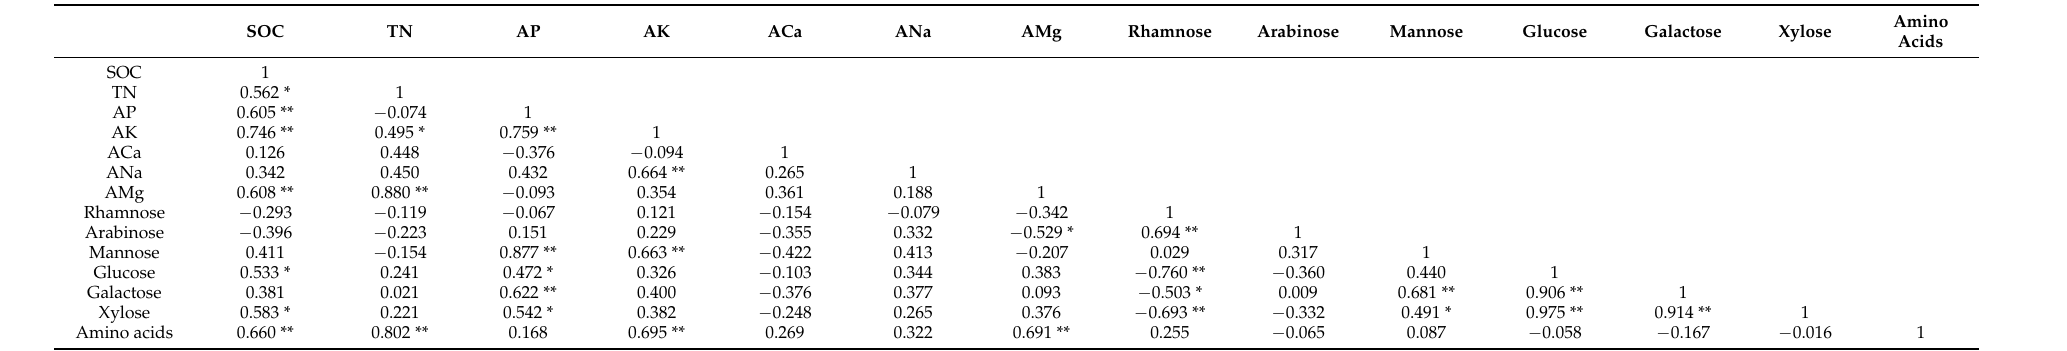
Table 4. Correlation coefficients between various soil nutrient indices (* p < 0.05; ** p < 0.01).